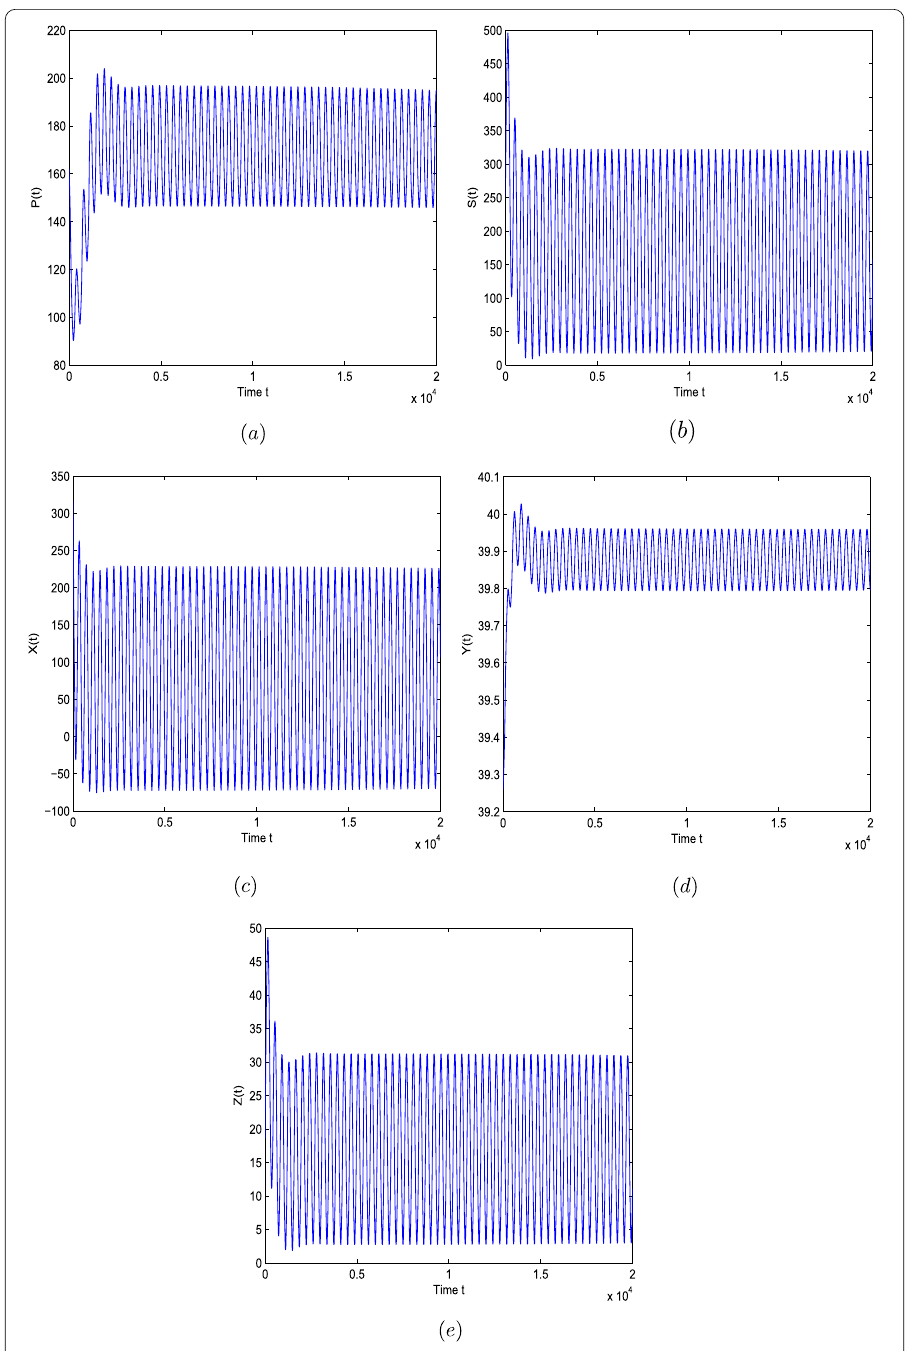
Figure 4 The equilibrium E ∗ of system (21) is unstable for τ = 122.905 > τ 0